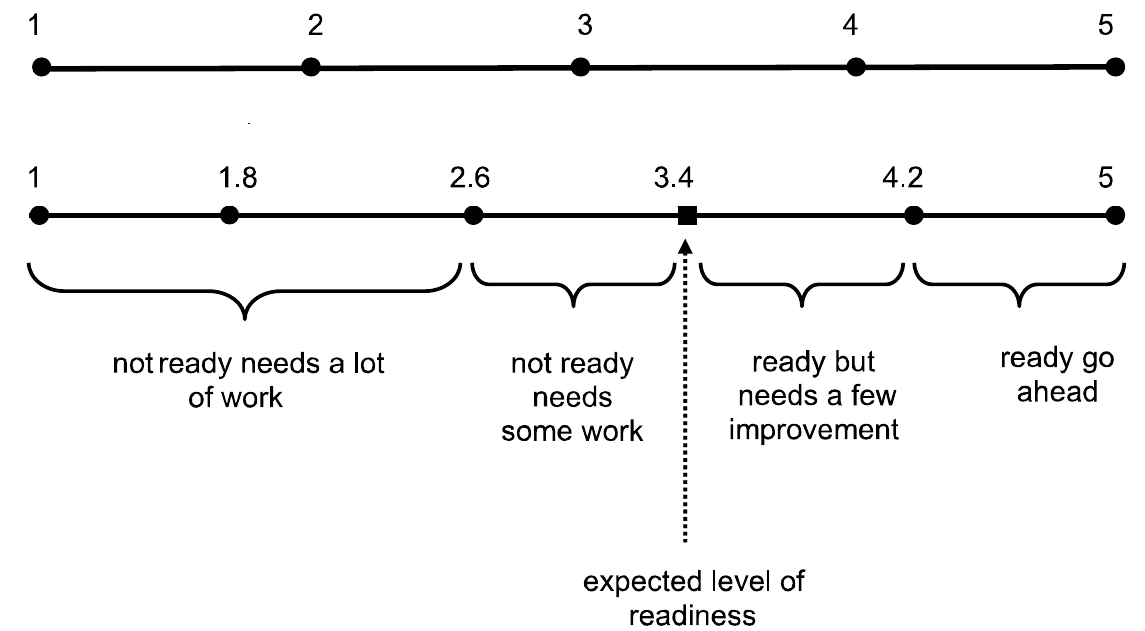
Figure 2. Levels of measuring e ‐ readiness (Ayd ı n & Tasci,